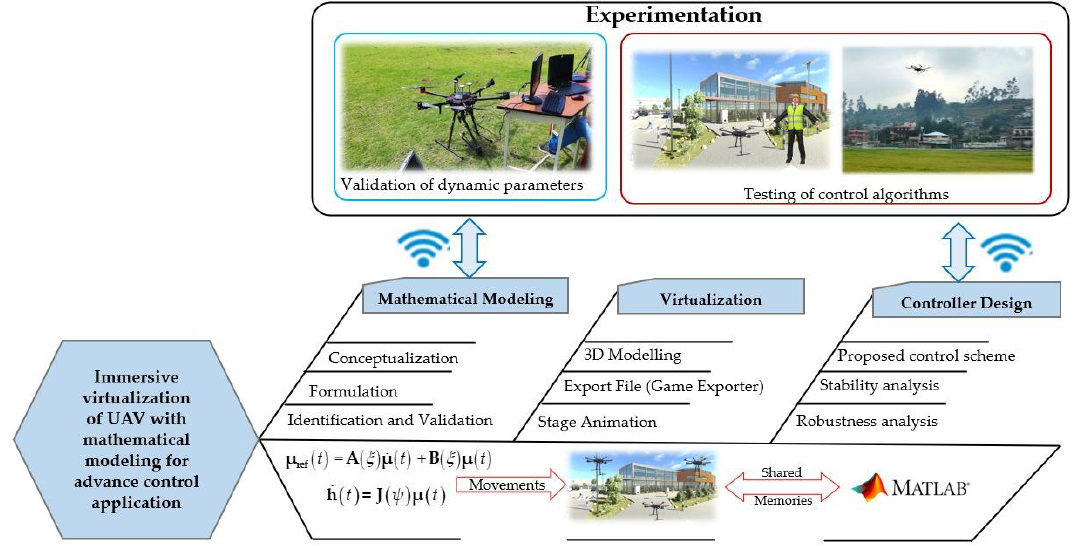
Figure 1. Methodology for the control and virtualization of UAVs.